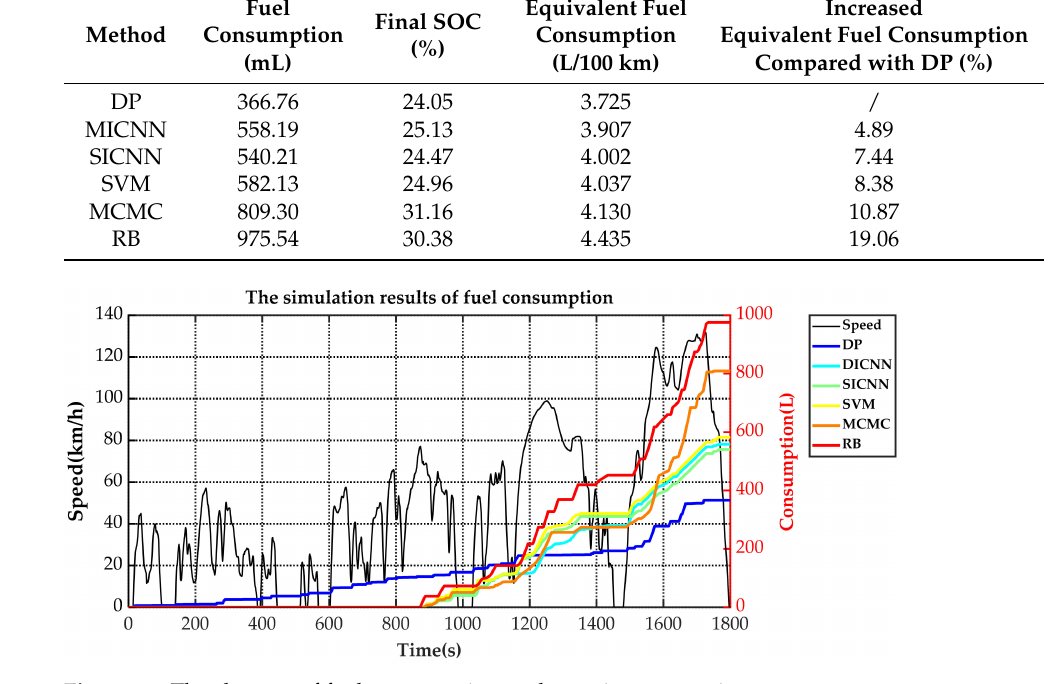
Figure 15. The changes of fuel consumption under various strategies.